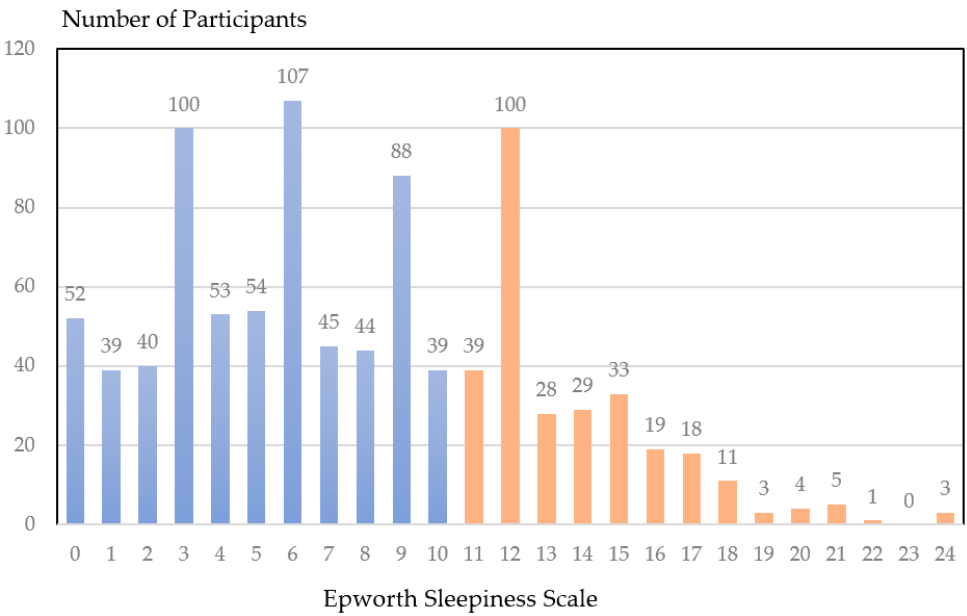
Figure 2. Distribution of the Epworth sleepiness scale among the emergency physicians. The x -axis is the Epworth sleepiness scale, and the y -axis is the number of participants. An Epworth sleepiness scale of 11 or more colored orange indicated the presence of excessive daytime sleepiness.